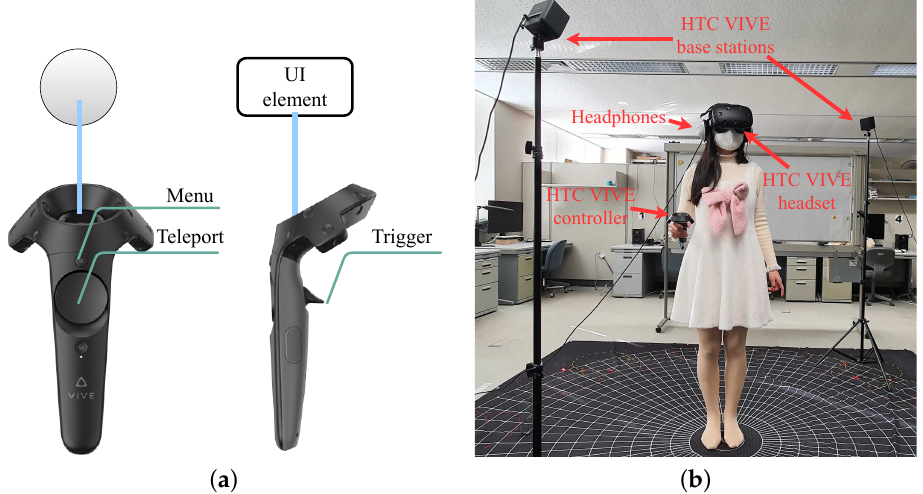
Figure 2. HTC VIVE controller with implemented user interface functionalities and a user in the real settings. ( a ) Controller. ( b ) Real